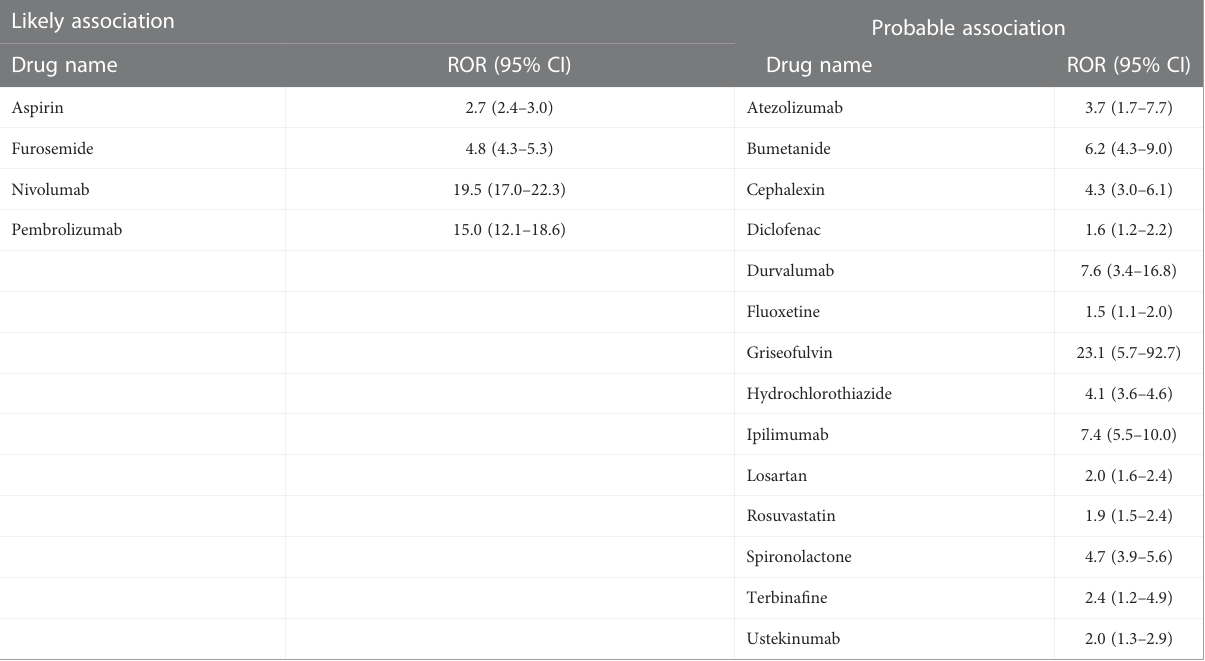
TABLE 1 List of BP-risk drugs categorized as ‘ likely ’ or ‘ probable ’ association with BP in a previous study (16) showing a signi fi cant increase in ROR for BP in our analysis, as indicated in Supplemental Table 1 BP_DrugA. Likely association